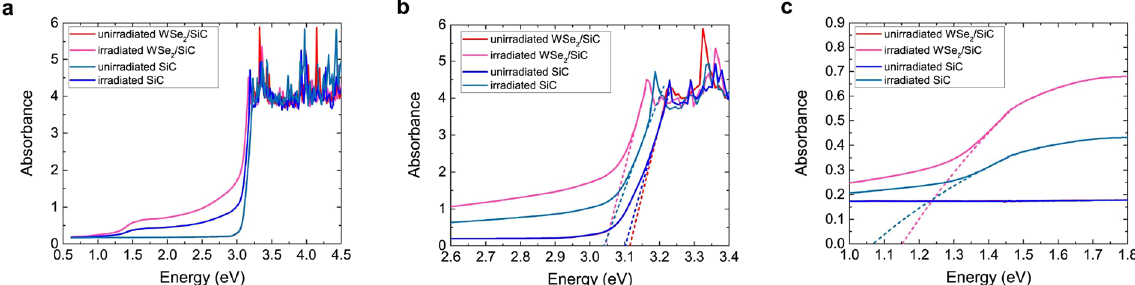
Figure 3. UV-Vis-NIR spectra before and after 2 MeV proton irradiation at a fluence of 10 16 protons/cm 2 . ( a ) The measured UV-Vis-NIR spectra reveal irradiation-induced changes in the optical properties of the SiC substrate. Magnified regions of the plot ( a ) depicting the changes in the absorption edge corresponding to ( b ) the SiC band gap and ( c ) the new absorption edge created around 1.1 eV due to the irradiation-induced vacancy-rich region deep in the SiC substrate. Projected range in ( dE / dx ) nucl at WSe 2 ( dE / dx ) elec . at WSe 2 bulk WSe 2 ( μ m) surface (MeV cm 2 /mg) surface (MeV cm 2 /mg) Dpa in WSe 2